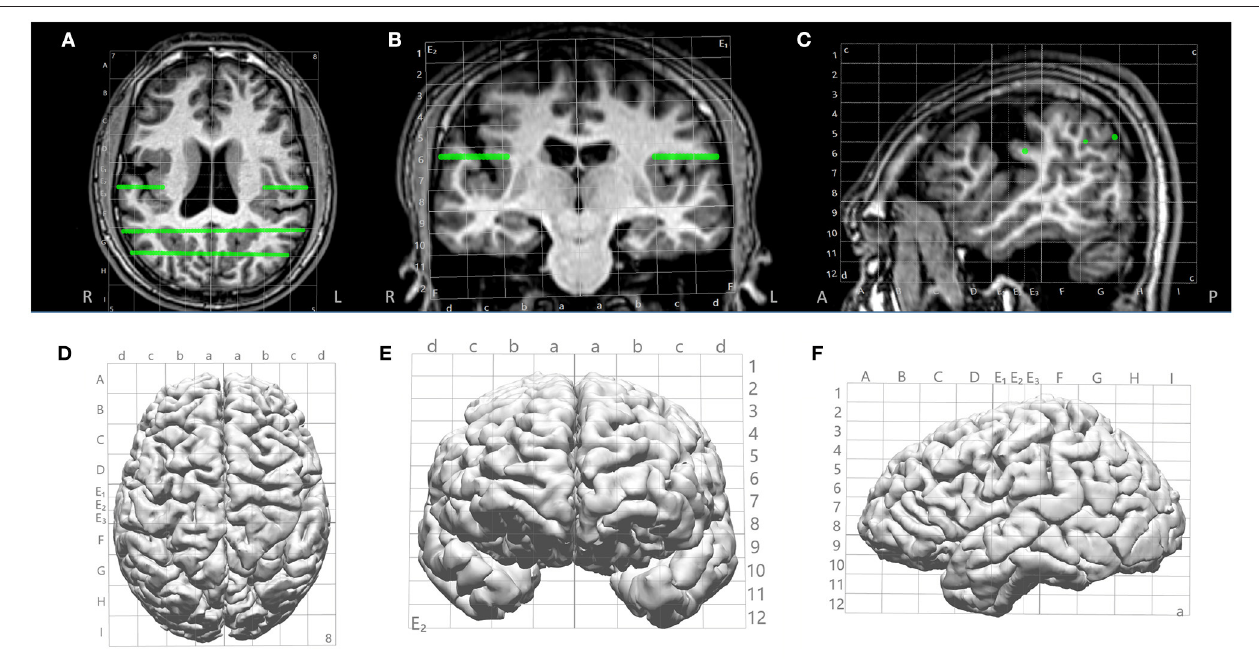
FIGURE 2 | Illustration of Talairach grid defined based on AC, PC and MS points identified on the 3D T1-weighted base image. (A–C) 2D overlay of the Talairach grid on coronal, axial and sagittal MRI; (D–F) 3D overlay of the Talairach grid on cortical surface (axial, coronal and saggital). Green lines indicate electrode trajectories.